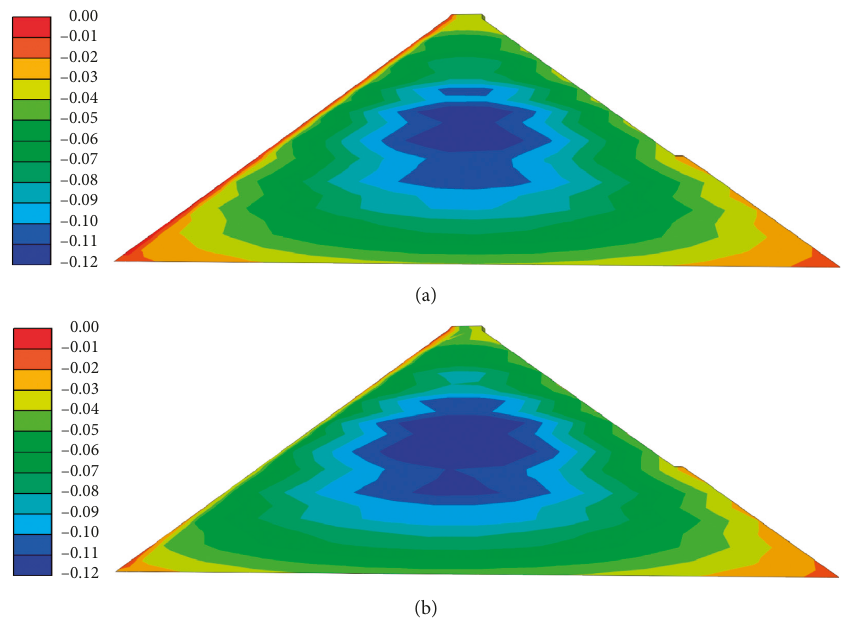
Figure 14: Settlement distribution in section A-A at the end of (a) construction and (b) impounding.